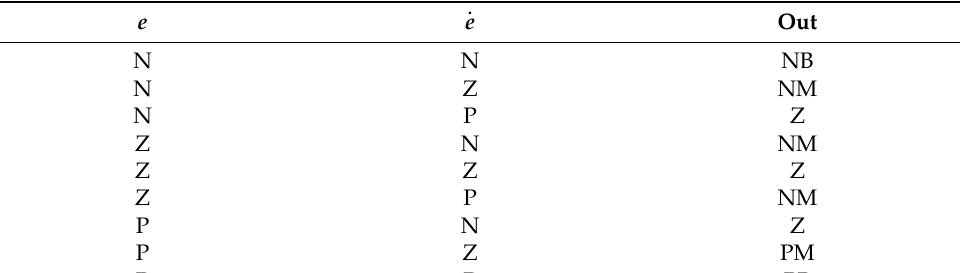
Table 3. Fuzzy rules used by the FC.